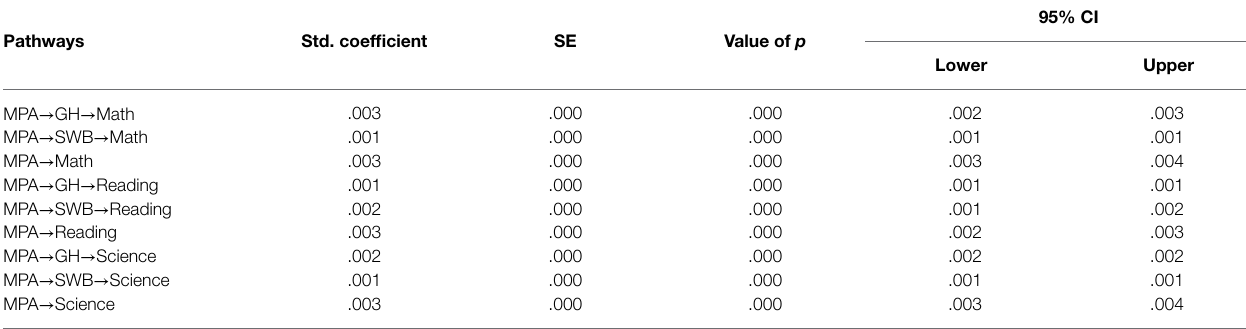
TABLE 6 | Standardized indirect effects and 95% confidence intervals for the model ( N = 63,228).